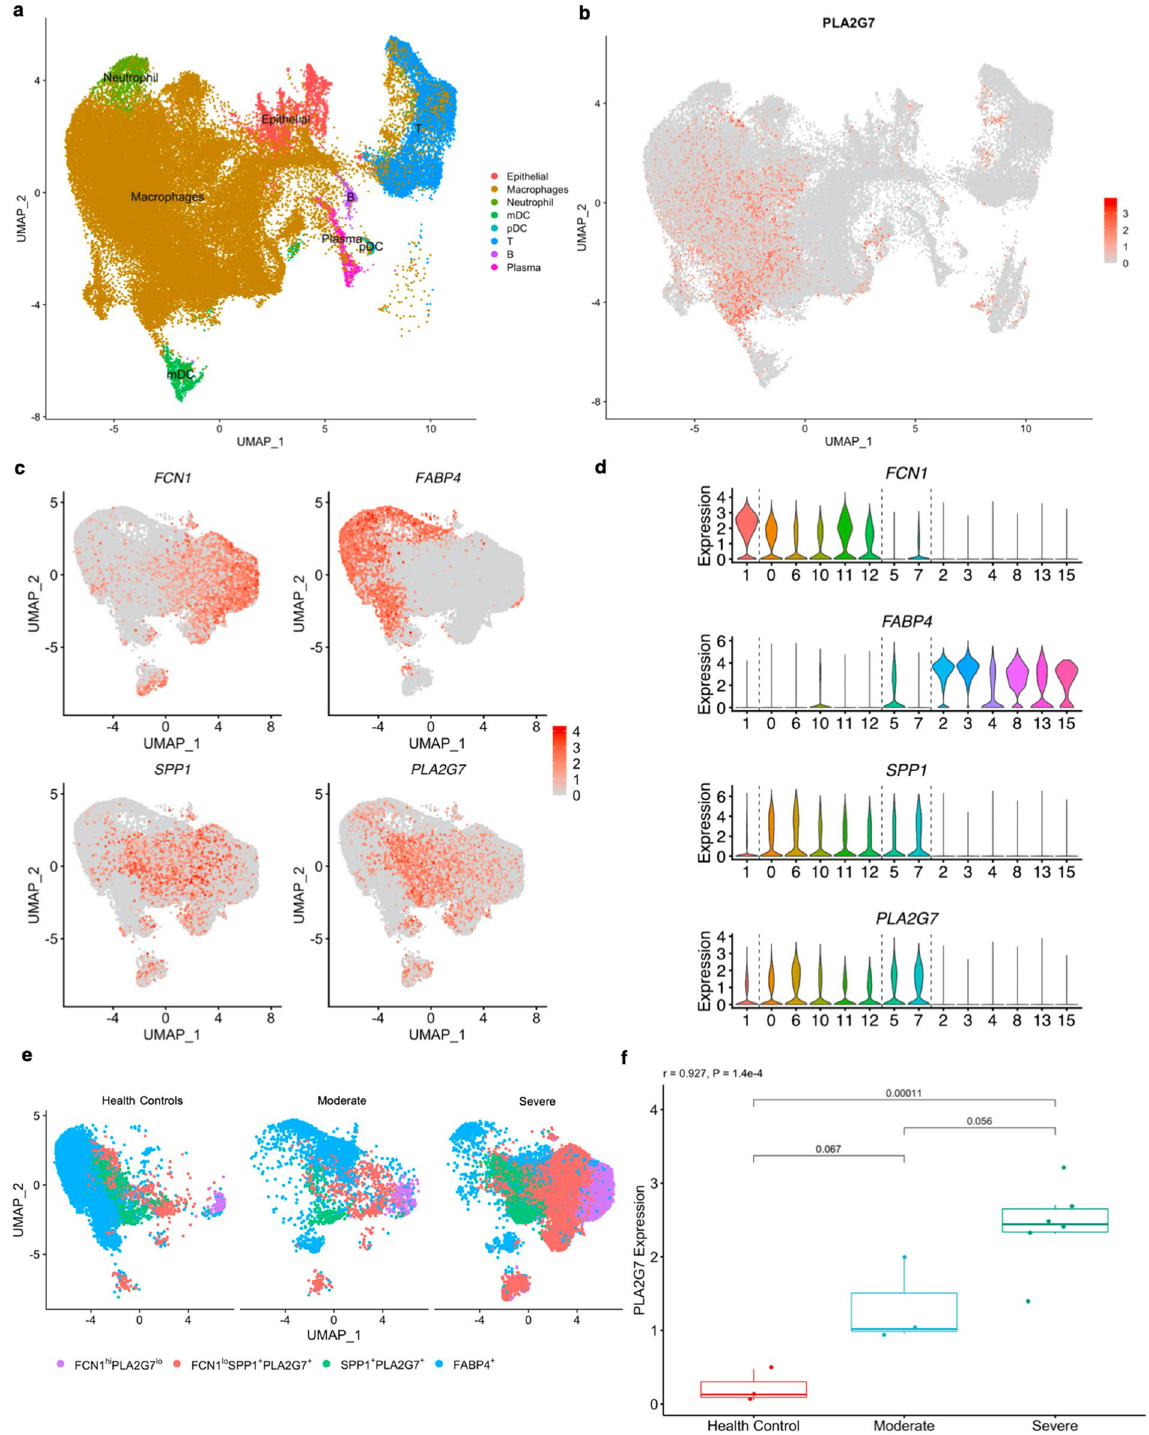
Figure 2. PLA2G7 was induced by proinflammatory macrophages emerging along with progression of COVID-19. ( a ) UMAP presentation of major cell types in bronchoalveolar lavage fluids (BALFs) from patients with COVID-19 in GSE145926. ( b ) UMAP plot showing the expression of PLA2G7 across the immune cells. ( c ) UMAP maps showing the expression of PLA2G7, along with the markers (SPP1, FCN1 and FABP4) in re-integrated macrophages. ( d ) Macrophages were classified into 4 groups based on the expression of FCN1, FABP4, SPP1 and PLA2G7, indicating by dashed lines. ( e ) UMAP projection of four macrophage groups among the health controls, patients with moderate and severe COVID-19, indicating the dynamic changes of macrophages in different patients. ( f ) Expression of PLA2G7 was correlated with progression of COVID-19. UMAP, Uniform Manifold Approximation and